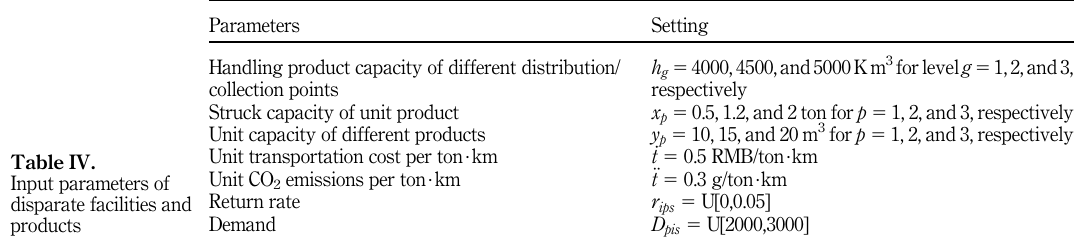
Table III. Fixed emissions emitted by facilities